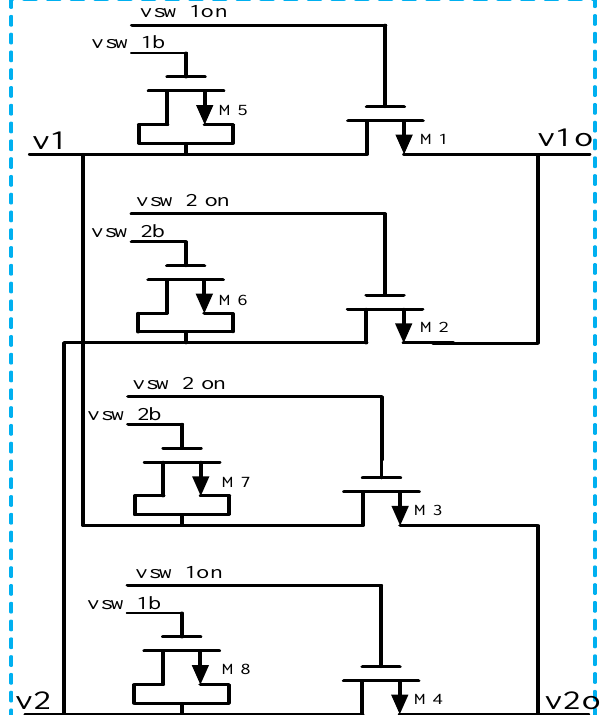
Figure 8. Schematic of the chopper circuit.